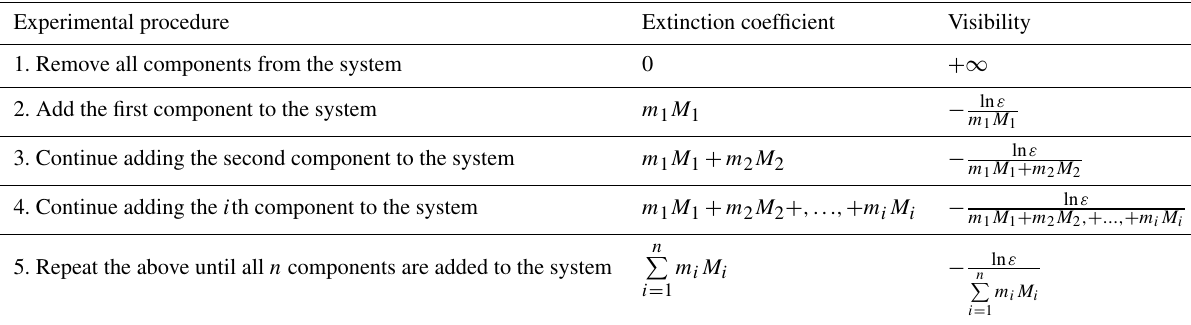
Table 1. Records of the thought experimental procedures. Experimental procedure Extinction coefficient Visibility